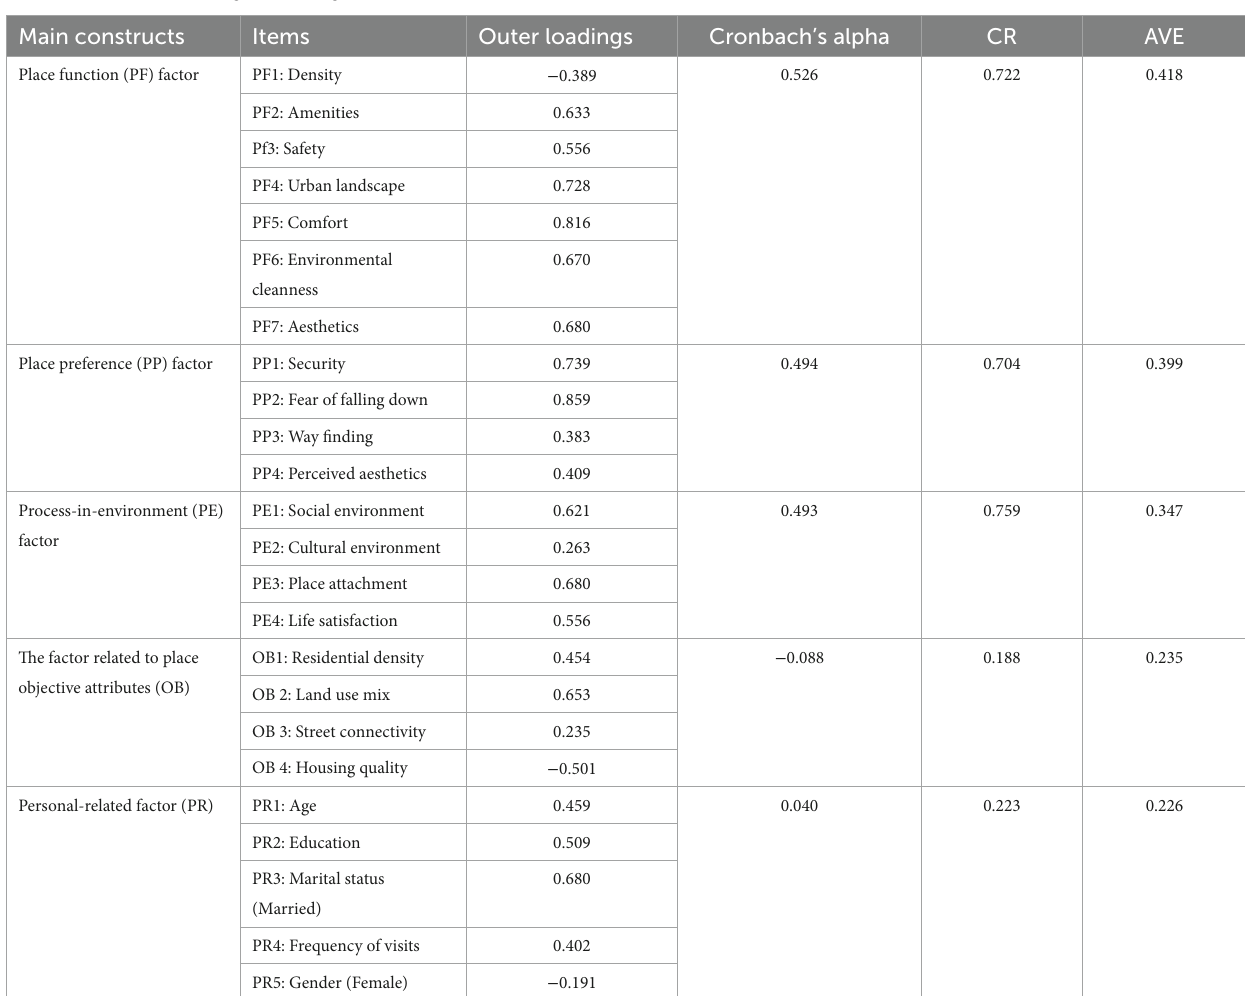
TABLE 2 Construct reliability and validity.